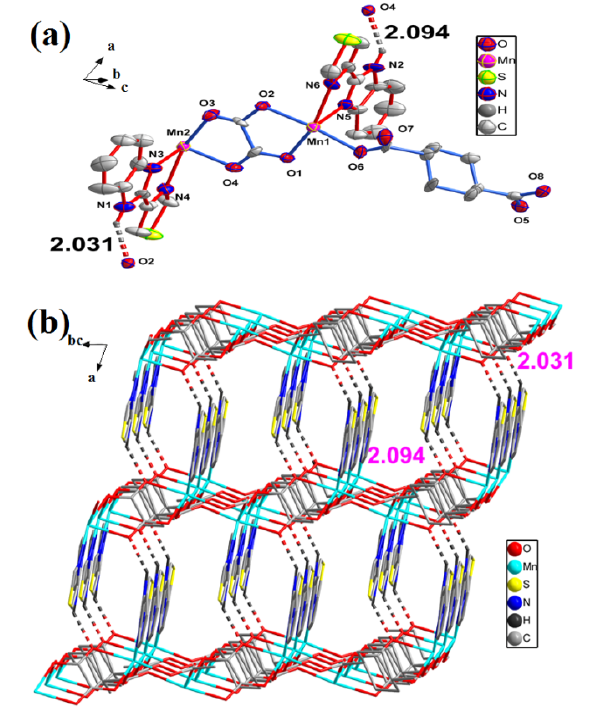
Figure 4. ( a ) A perspective view of H-bonding for complex 1 . Unnecessary atoms are omitted for clarity. ( b ) View of the 3-D coordination topology network created by the H-bonding and the TBZ ligand.